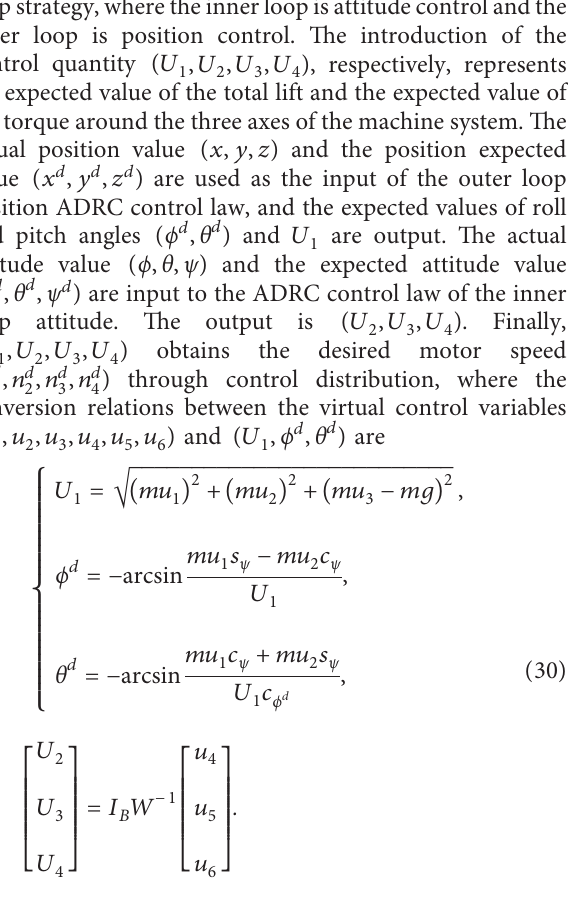
The expressions of the fastest tracking control integrated , x , r, h ) and nonlinear function fal ( e, α , δ function fhan ( x 1 2